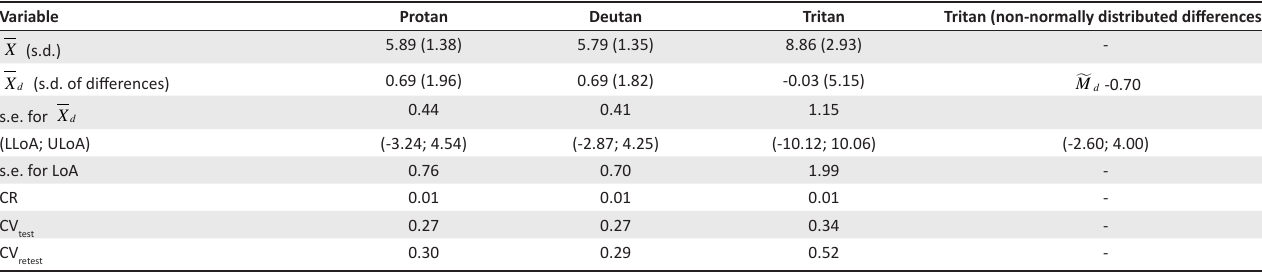
TABLE 3: Descriptive statistics for the Bland–Altman plots in Figure 5. Variable Protan Deutan Tritan Tritan (non-normally distributed differences) X (s.d.)